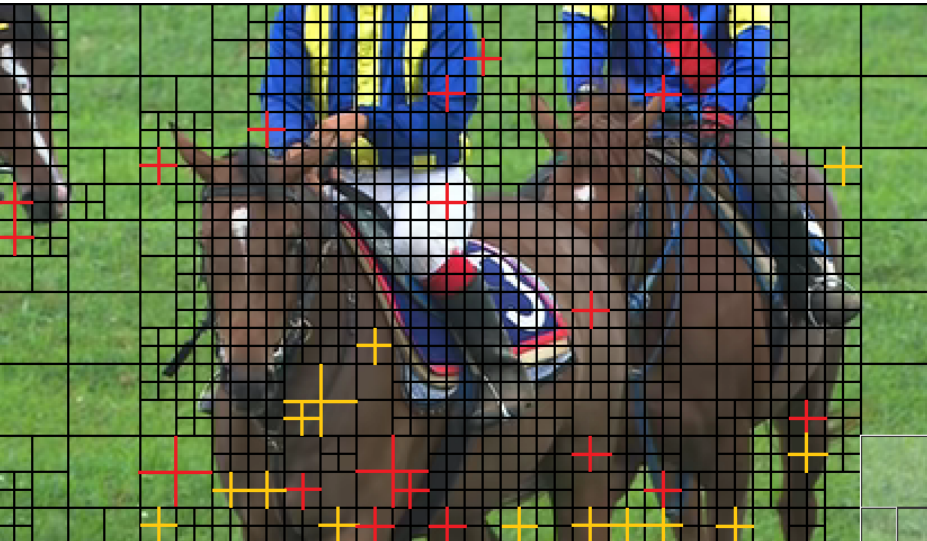
Figure 13. Partition results of the 180th frame in the sequence RaceHorses (416 × 240), which is encoded by the third version BTRNFA joint of the proposed algorithm with QP 22. The black line represents the same partition results as those of the original HM16.7. The gold line represents the boundaries of CUs, which are split by the original HM16.7 but are not split by the BTRNFA joint . The boundaries of CUs, which are non-split by the original HM16.7 but are split by the BTRNFA joint , are shown with a red